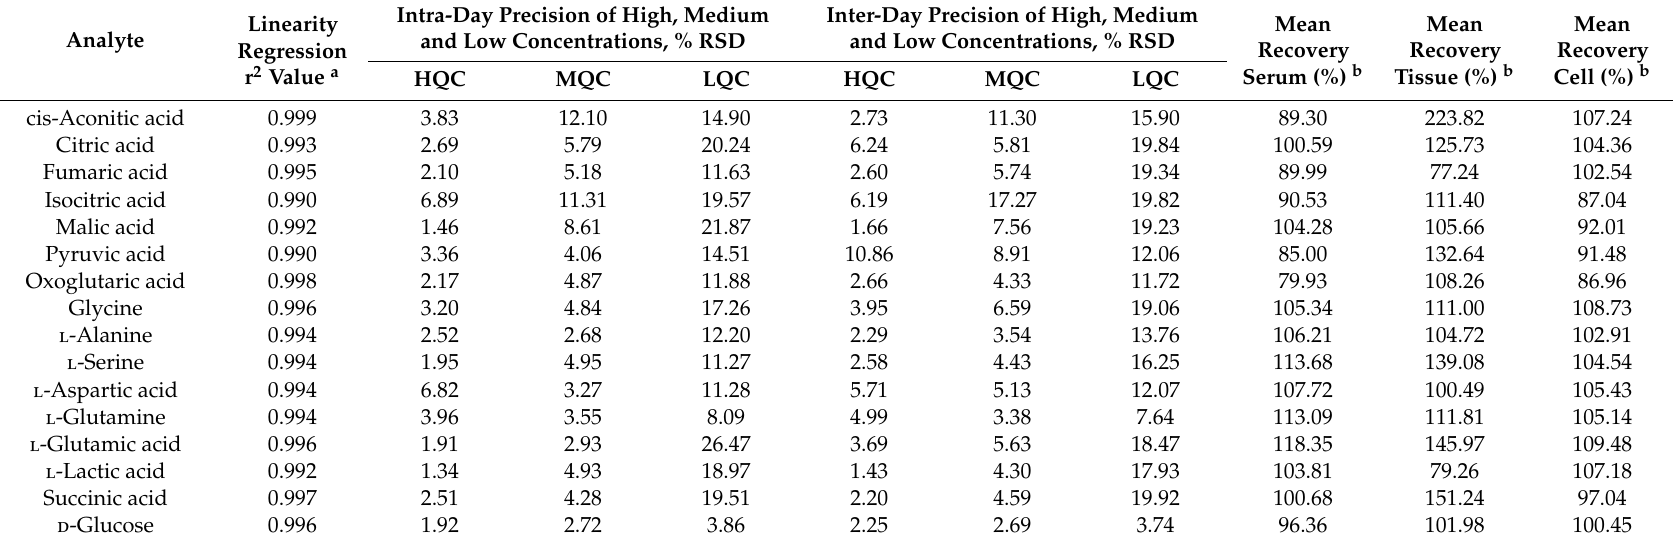
Table 2. Results of recovery, intra- and inter-day precision of TCA cycle intermediates in Serum and